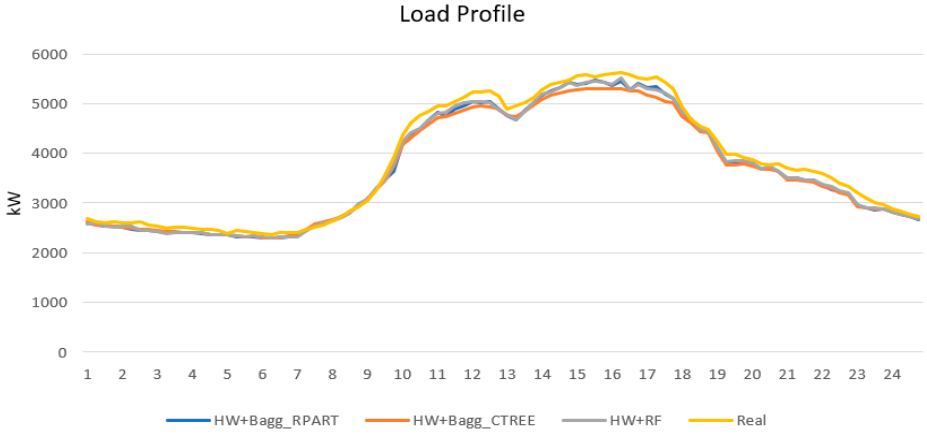
Figure 6. Load profile used in simulation. Table 3. Simulation case.